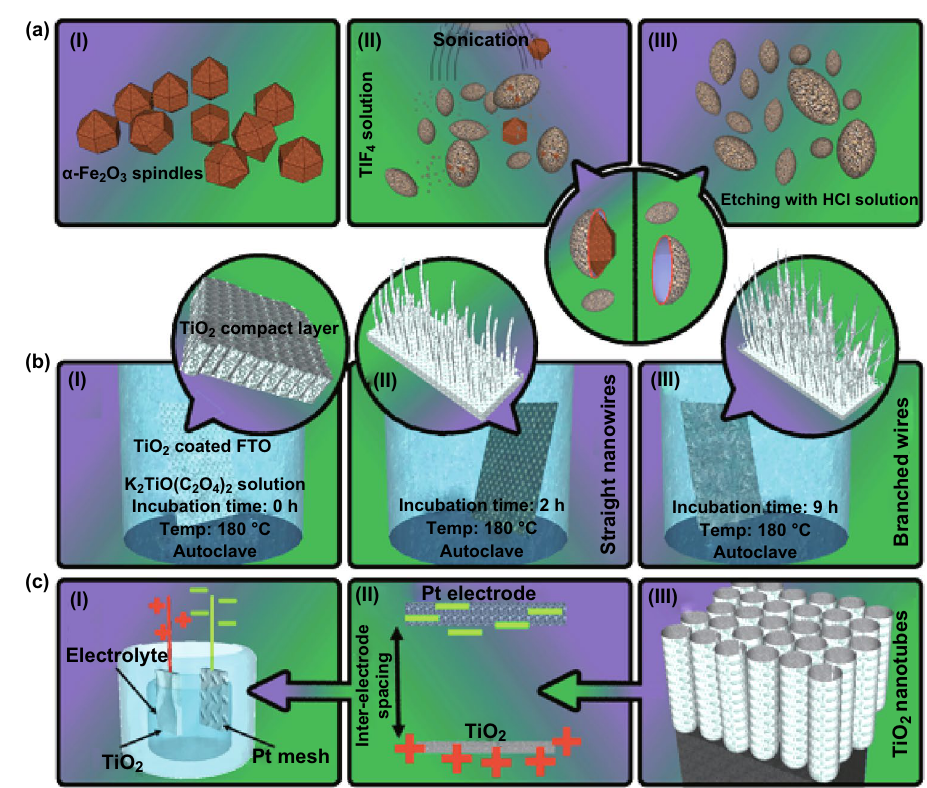
Fig. 1 Simplified schematic representation of fabrication techniques for TiO 2 nanomaterials. a Non‑spherical, hollow, and magnetically loaded particles fabricated through a template‑assisted, bottom‑up strategy. Adapted from Ref. [49] with permission from the John Wiley & Sons. b The hydrothermal approach is one of the bottom‑up strategies for the fabrication of a wide range of one‑dimensional TiO 2 NSs. The TiO 2 precursor, temperature, and incubation time determine the final nanostructure. Adapted from Ref. [55] with permission from the Springer Nature. c Well‑ aligned and ordered TiO 2 nanotubes can be fabricated through a top‑down strategy based on electrochemical anodization. Adapted from Ref. [74] with permission from the American Chemical